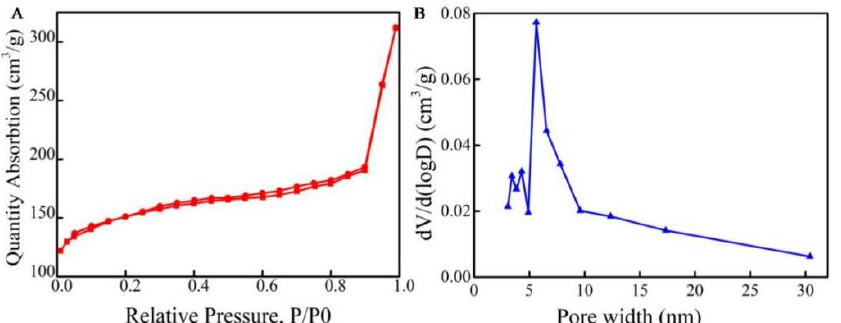
Figure 3. Brunauer–Emmett–Teller (BET) surface area and pore size distribution curves. ( A ) N 2 Figure 3. Brunauer – Emmett – Teller (BET) surface area and pore size distribution curves. ( A ) N 2 ad- sorption – desorption isotherms of MCNs. ( B ) Pore size distribution of MCNs. adsorption–desorption isotherms of MCNs. ( B ) Pore size distribution of